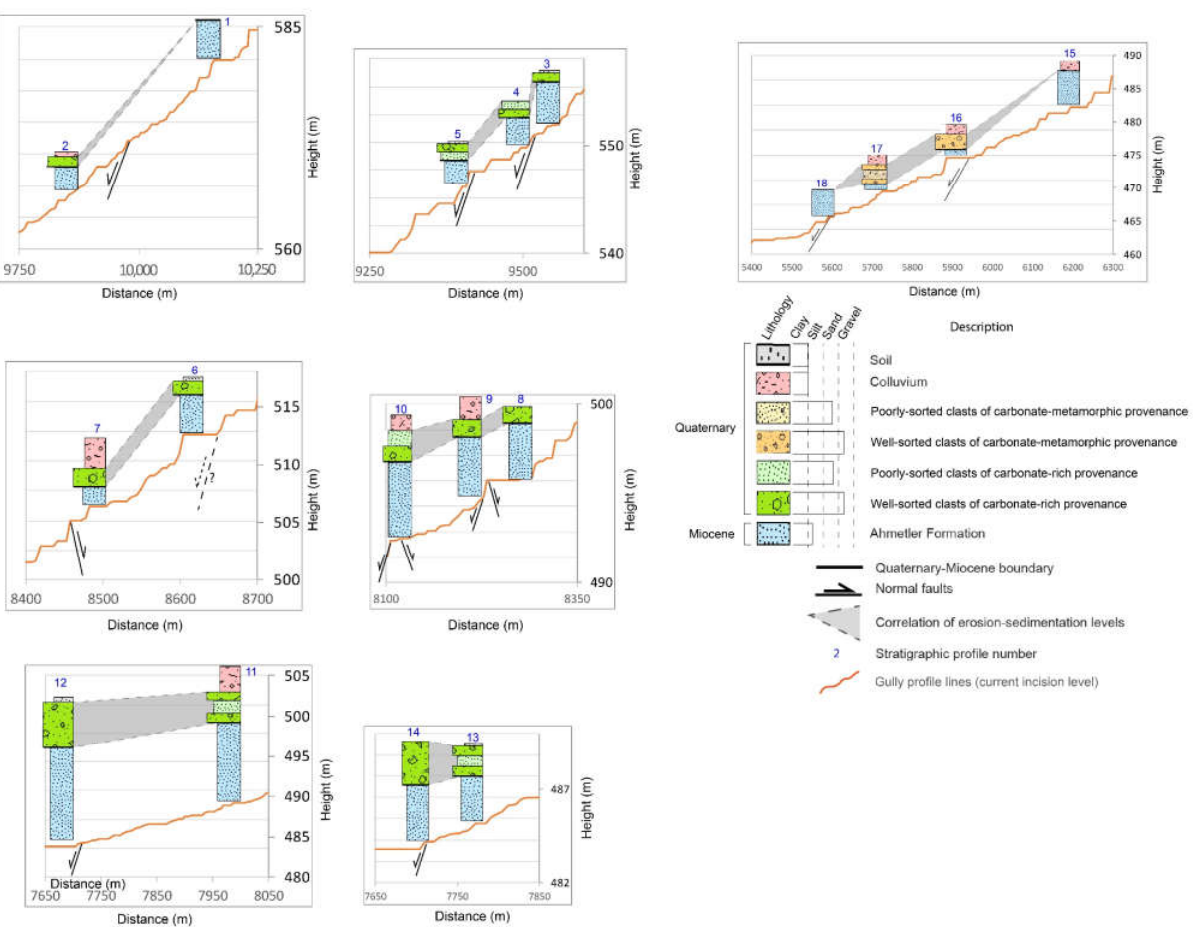
Figure A1. Correlated Quaternary sedimentary units are shown with stratigraphic logs with their position in the gully, current incision levels, faults and their textural differences. Stratigraphic columns 1–14 are from gully Z1, and columns 15–18 are from gully X in Figure 5. Stratigraphic columns (from 1 to 18) are explained in Table 1.